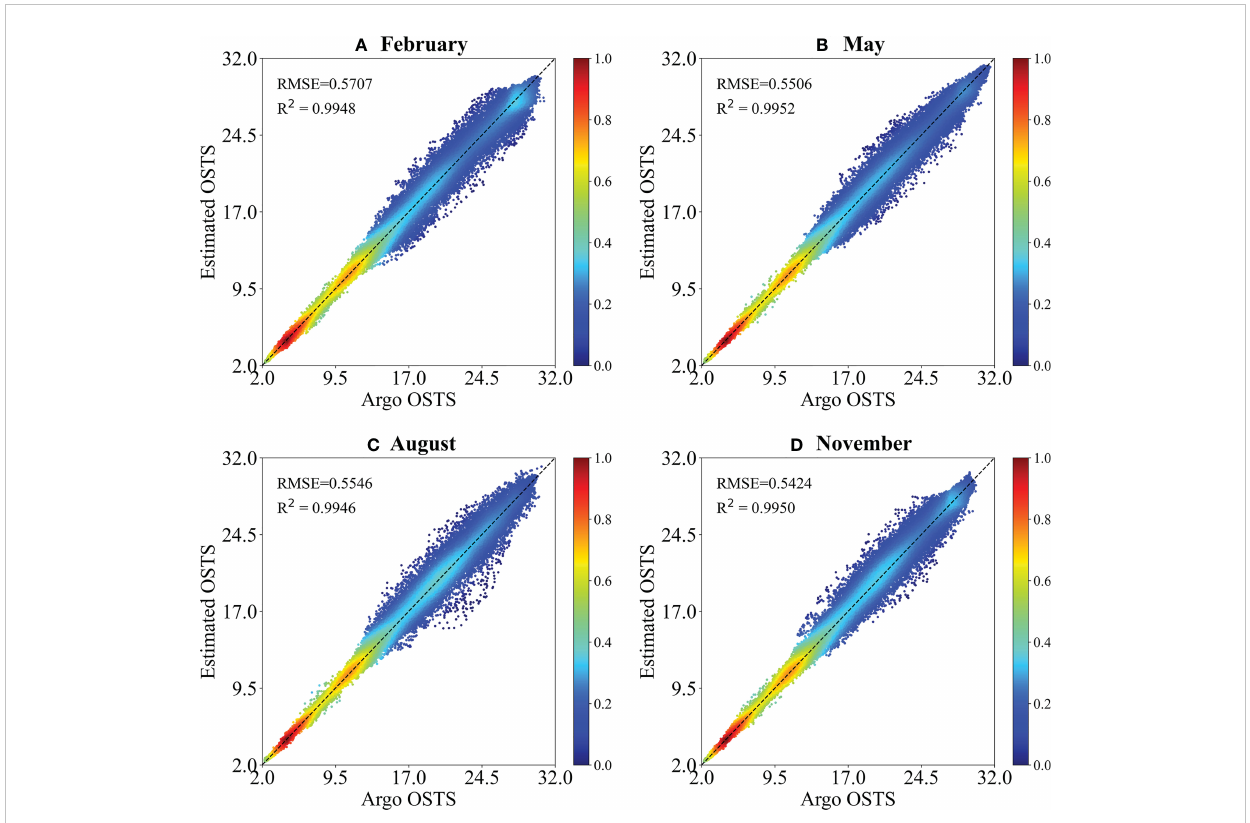
FIGURE 10 Scatter plots of temperature from Argo observation and CBAM-CNN model estimation in (A) February, (B) May, (C) August, and (D) November in